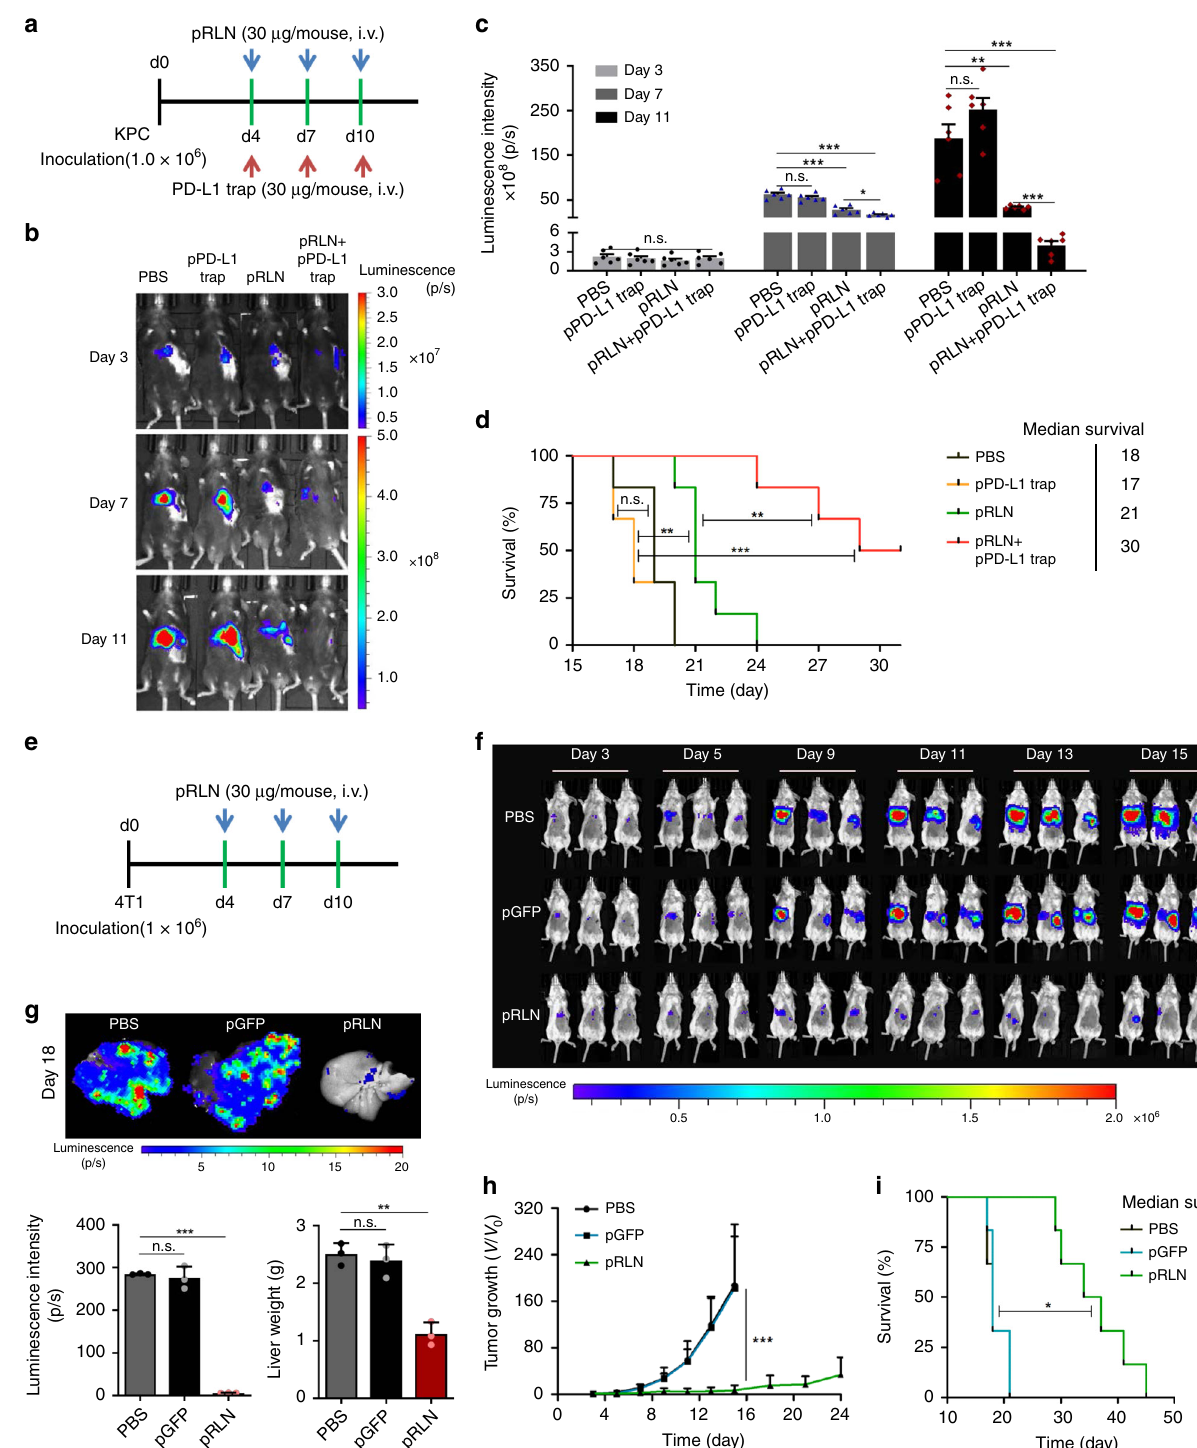
Fig. 6 RLN and PD-L1 blockade gene-immune therapy on KPC and 4T1 liver metastases. a KPC tumor inoculation and treatment scheme. b Representative in vivo bioluminescence imaging of mice bearing KPC liver metastasis receiving various treatments on days 3,7, 11 post tumor inoculation. c Quanti fi cation analysis of KPC liver metastasis burden by bioluminescence intensity ( n = 6). d Survival curves of mice bearing KPC liver metastasis in each treatment group ( n = 6). e 4T1 tumor inoculation and treatment scheme. f Representative in vivo bioluminescence imaging of mice bearing 4T1 liver metastasis receiving various treatments. g Imaging and quanti fi cation analysis (both bioluminescence and liver weight) of ex vivo 4T1 liver metastasis burden from PBS, pGFP LCP, and pRLN LCP 18 days after tumor inoculation ( n = 3). h Metastatic growth curves of 4T1 liver metastasis in each treatment group ( n = 5). i Mice survival curves in each treatment group ( n = 5). Signi fi cant differences were assessed in ( c , g ) using t test, in ( h ) using two-way ANOVA with multiple comparisons, in ( d , i ) using log rank test. Results are presented as mean (SD). * p < 0.05, ** p < 0.01, *** p < 0.001, n.s., not signi fi